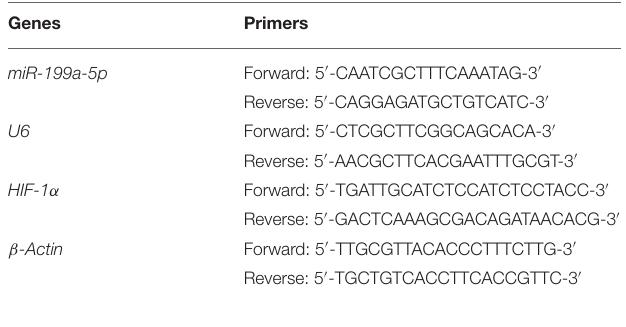
TABLE 1 | Primers used for